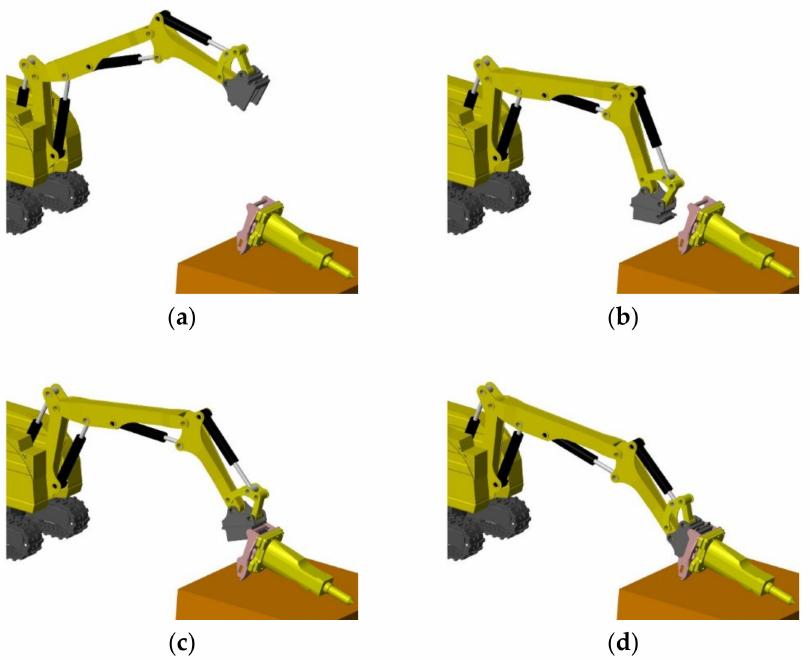
Figure 2. Attachment changing procedure: ( a ) initialization, ( b ) preparation, ( c ) range alignment, and ( d ) angle